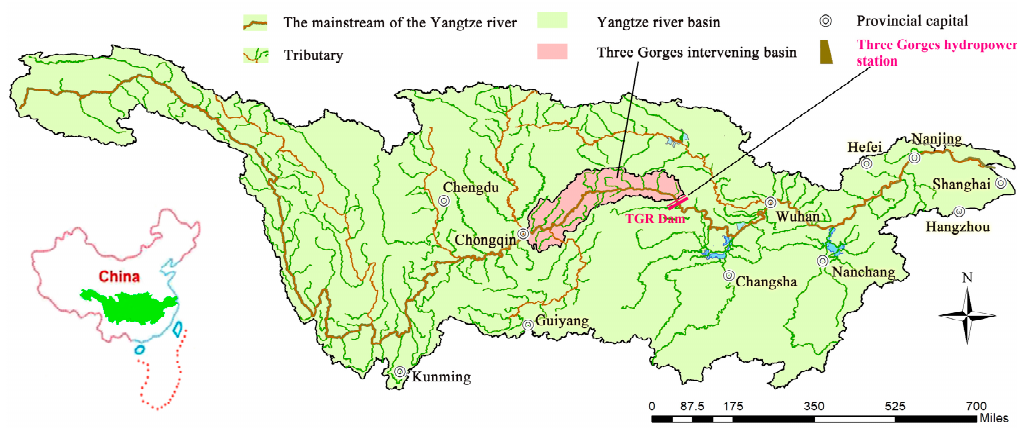
Figure 5. The location of the Three Gorges Reservoir (TGR).